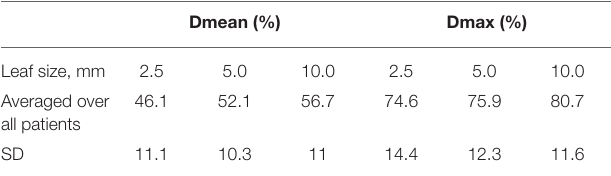
TABLE 4 | Dose fall-off at 5mm from PTV for each of the three MLC leaf sizes. TABLE 5 | Dose to normal tissue for each of the three MLC leaf sizes expressed in % of prescription